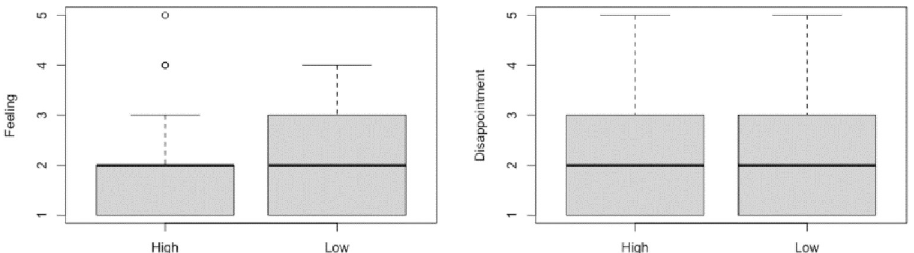
Fig 3. Box and whisker plots displaying the median and IQR of responses to the feeling and disappointment question in the two conditions.